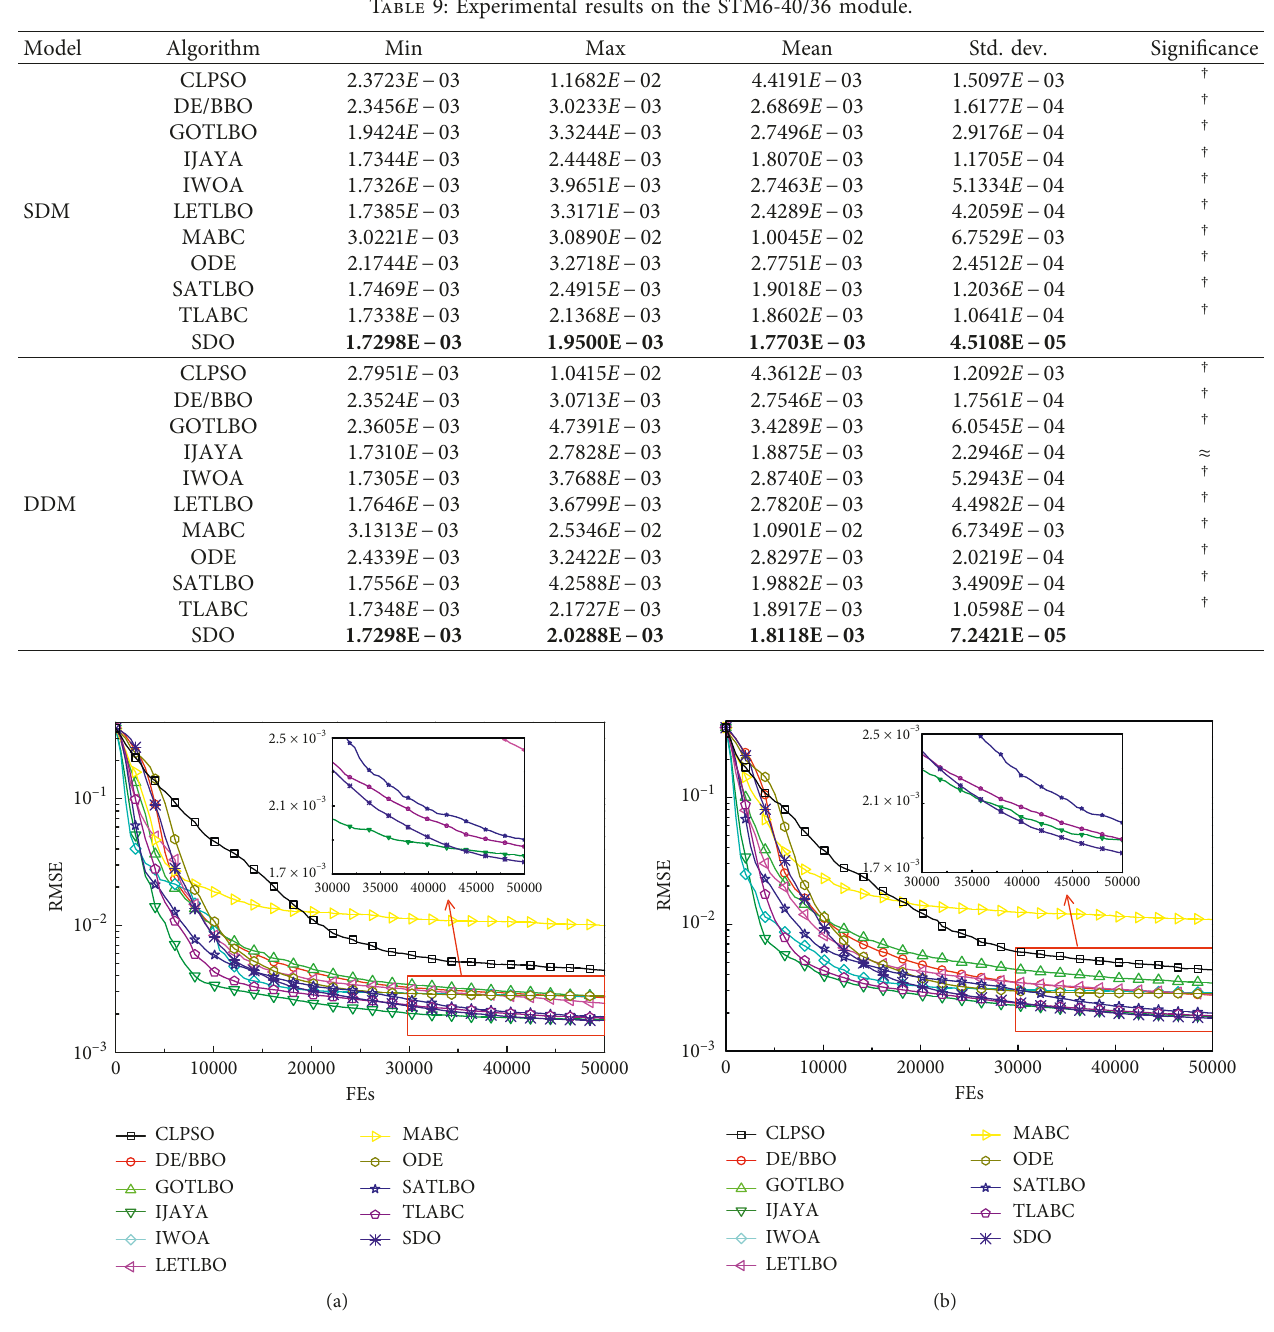
Figure 9: Convergence curves for the STM6-40/36 monocrystalline module. (a) SDM; (b)